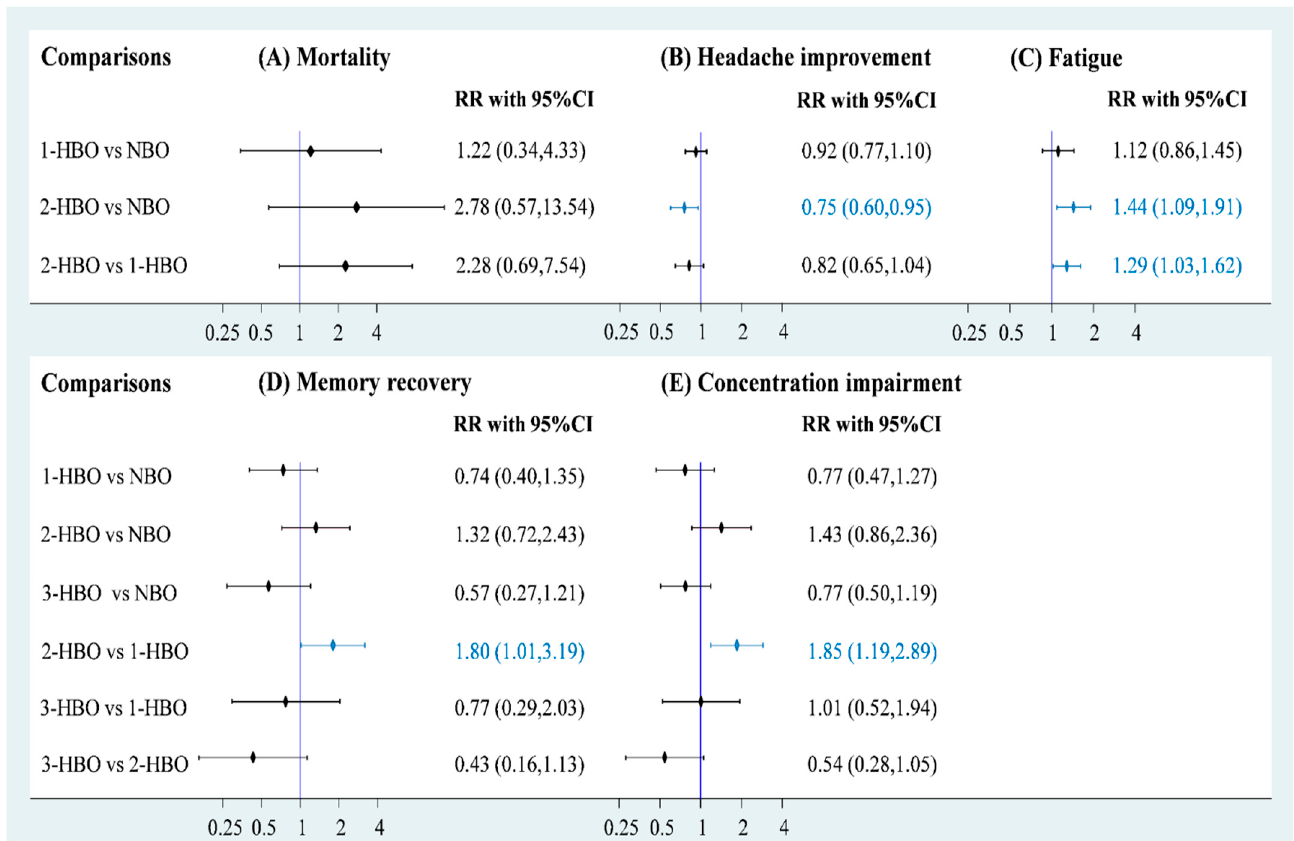
Figure 3. Forest plot of hyperbaric oxygen strategies of each outcome.